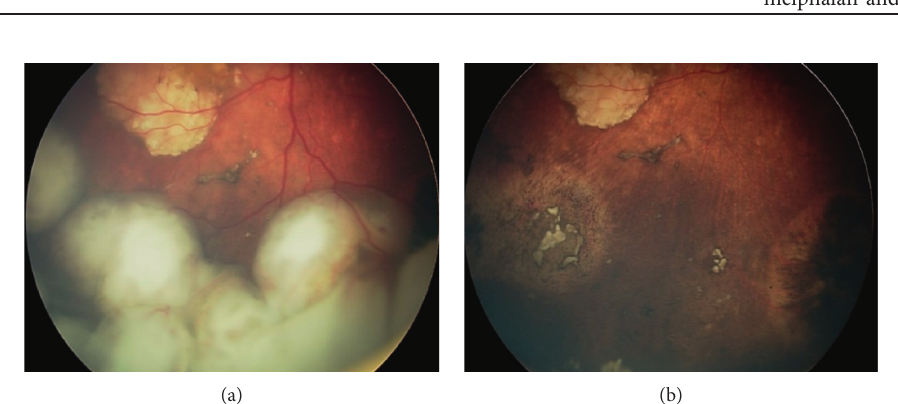
Figure 4: Intraocular retinoblastoma before and after treatement with intraarterial chemotherapy [18]. (a) Fundoscopic exam revealing an intraocular retinoblastoma before treatment with intra-arterial chemotherapy [see left] reproduced from Mario Zanaty et al. 2014, [under the Creative Commons Attribution 3.0 License]. (b) Fundoscopic exam revealing the same patient with intraocular retinoblastoma after treatment with intra-arterial chemotherapy [see left] reproduced from Mario Zanaty et al. 2014, [under the Creative Commons Attribution 3.0 License].